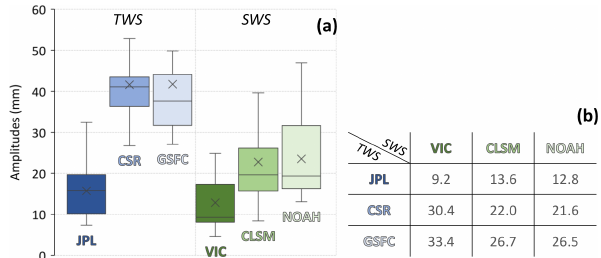
Figure 4. (a) Annual amplitude comparison between the three GRACE solutions and the three GLDAS products and (b) the asso- ciated RMSE of the linear regressions applied on these